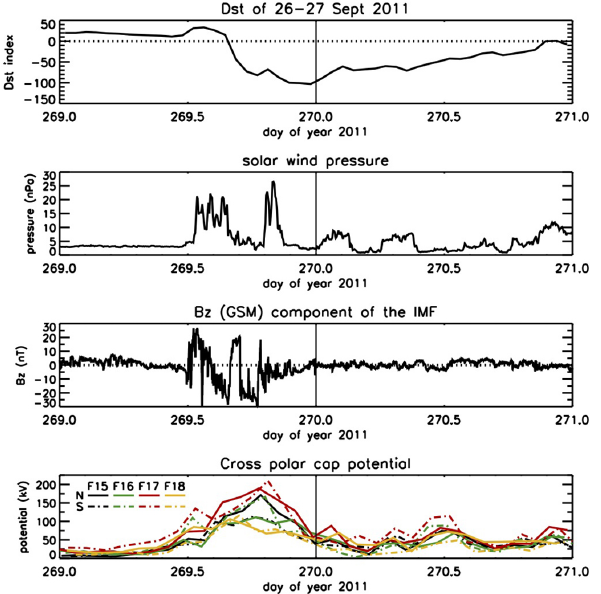
Figure 4. This figure repeats the data shown in Fig. 3 for just the storm day and recovery day (26–27 September) in an expanded form for easier examination.